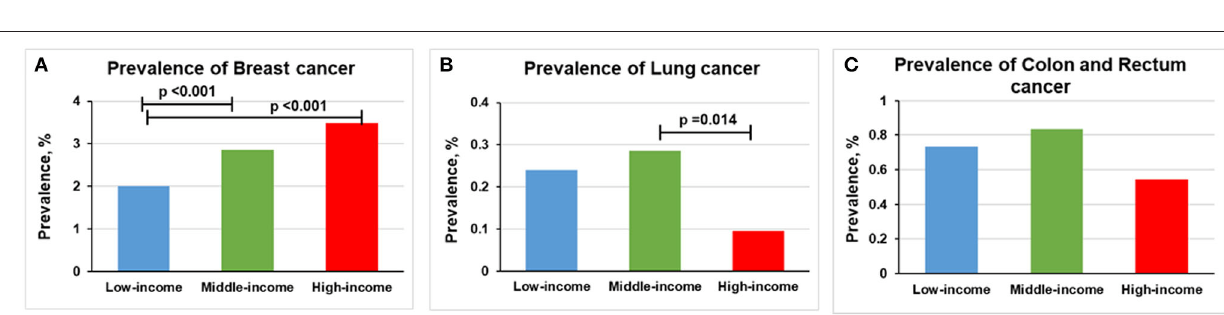
FIGURE 4 | Overall prevalence of cancer among women participants 20 years or older stratified by income group, 1999–2018. Significant at p < 0.0167 after Bonferroni correction. (A) Prevalence of breast cancer. (B) Prevalence of lung cancer. (C) Prevalence of colon and rectum